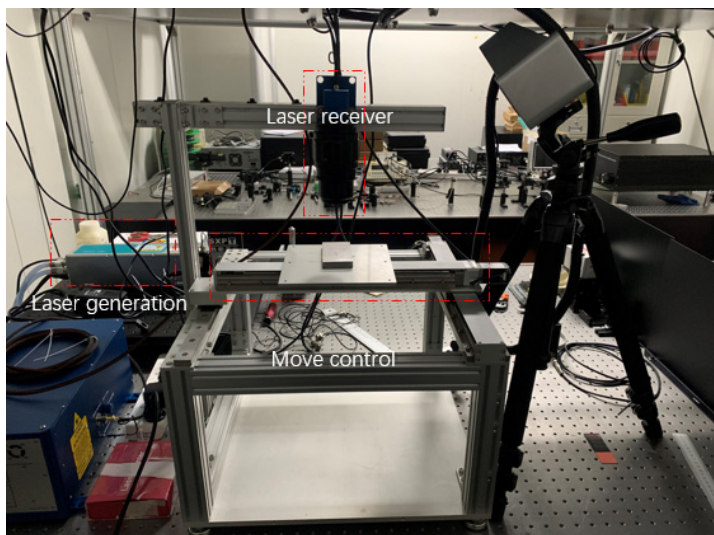
Table 2. The stainless ‐ steel (316L) parameters.